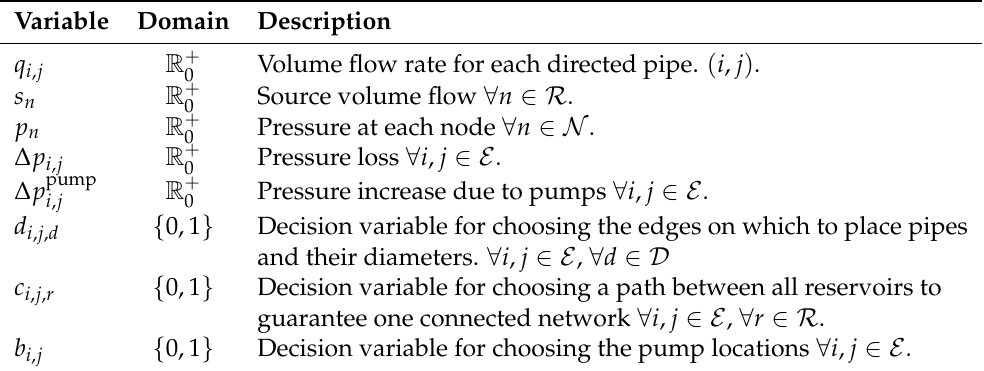
Table 3. Decision variables of the optimization problem.